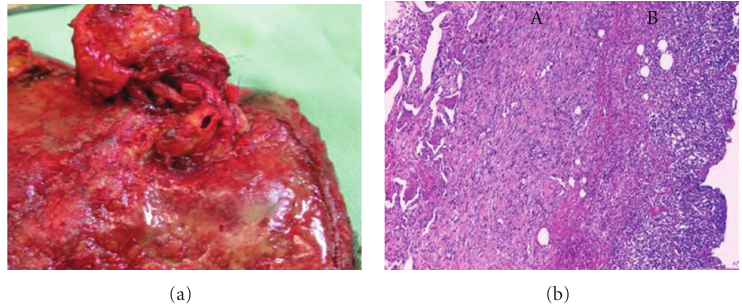
Figure 2: (a) Extensive inflammation of the resected lower lobe. (b) Lung parenchyma, B: pleura. Suppurative pan-pleuritis.